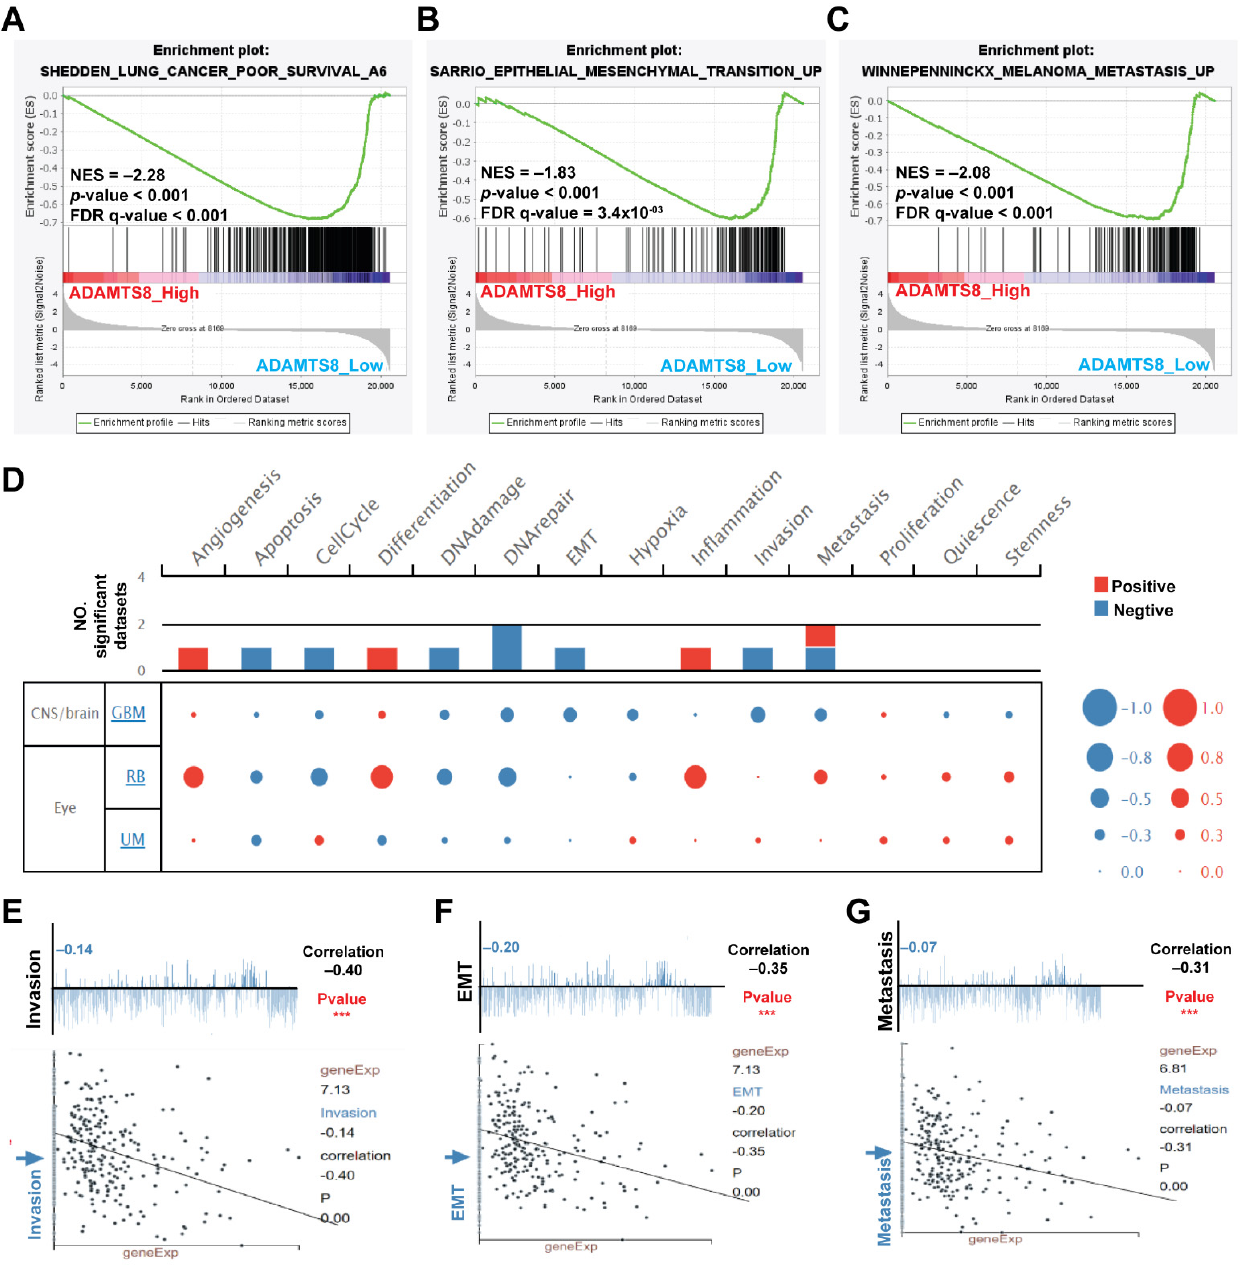
Figure 3. ADAMTS8 caused a more aggressive phenotype in lung adenocarcinoma. The GSEAs linked to low levels of ADAMTS8 were lung cancer, poor survival, EMT and metastasis in cancer ( A – C ). From the public database CancerSEA, ADAMTS8 mediates several cancer cellular behaviors, with positive correlations in angiogenesis, differentiation and inflammation and negative correlations in apoptosis, cell cycle, DNA damage, DNA repair, EMT, invasion and metastasis ( D ). The correlations in invasion, EMT and metastasis yielded values of − 0.4, − 0.35 and − 0.31, respectively ( E – G ). Abb. EMT, epithelial-mesenchymal transition; GBM, glioblastoma multiforme; RB, retinoblastoma; UM, uveal melanoma. *** p < 0.005. The DNA methylation, copy number variation and miRNA did not affect the expres- sion of ADAMTS8. To elucidate the possible mechanisms for ADAMTS8 dysregulation in lung cancer, we assessed several epigenetic regulatory mechanisms, such as DNA meth- ylation, copy number variation (CNV) and miR-RNA interaction. First, when utilizing the